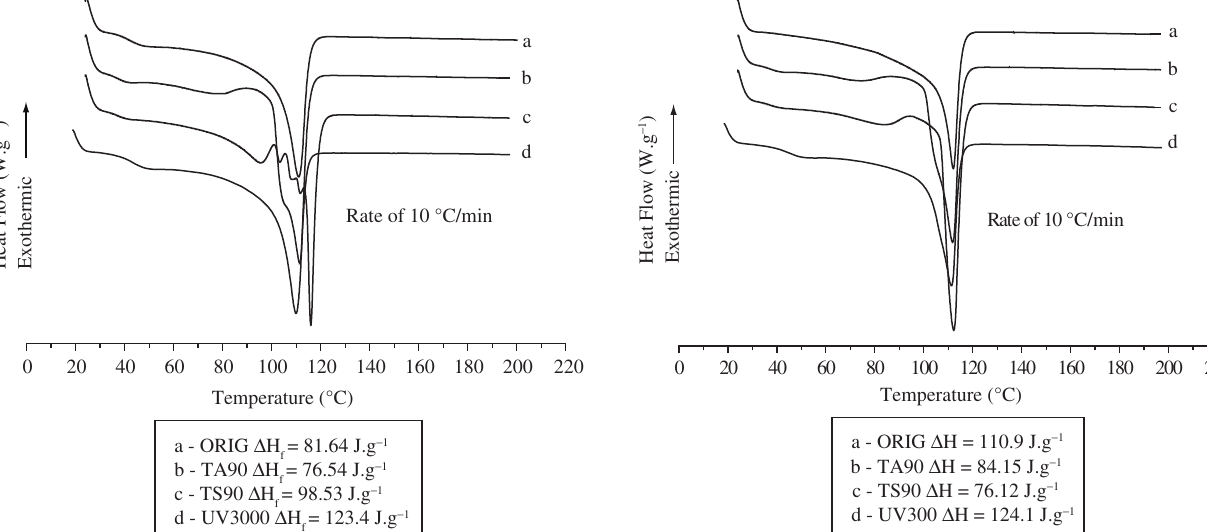
Figure 5. DSC thermogram for the LDPE CBC sample. Figure 6. DSC thermogram for the LDPE CBTS